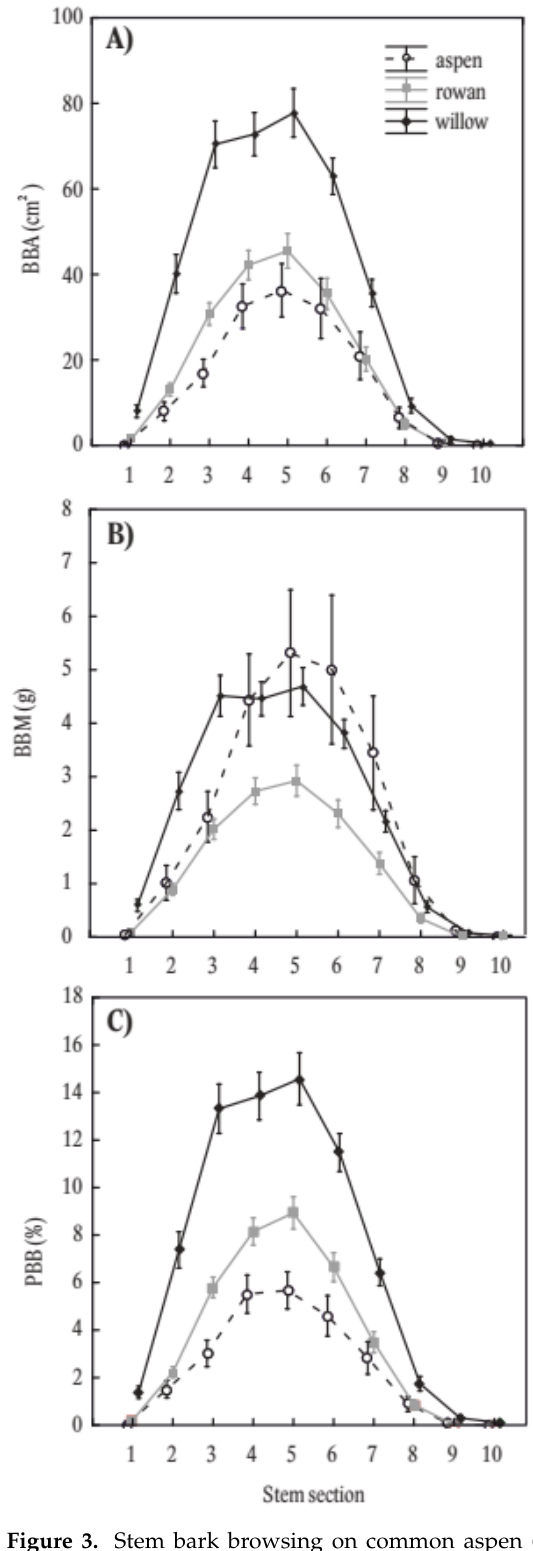
Figure 3. Stem bark browsing on common aspen ( Populus tremula L.), common rowan ( Sorbus aucuparia L.), and goat willow ( Salix caprea L.) considering the stem sections. Stem browsing is expressed on the basis of area ( A ), mass ( B ) and the proportion of browsed bark mass to full bark mass potential ( C ). The error bars indicate standard errors. The stem sections are coded as 1: 0–25 cm, 2: 26–50 cm, 3: 51–75 cm, 4: 76–100 cm, 5: 101–125 cm, 6: 126–150 cm, 7: 151–175 cm, 8: 176–200 cm, 9: 2: 201–225 cm, and 10: 226–250 cm from the ground level.